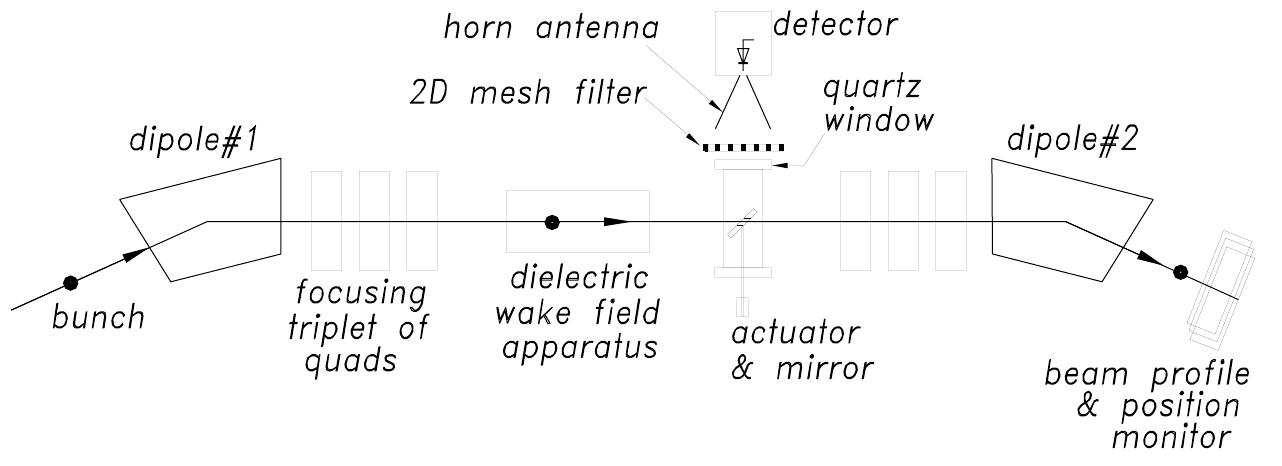
FIG. 2. Schematic of a portion of the beam line, showing transverse radiation output by use of a 45 (cid:3) deflecting